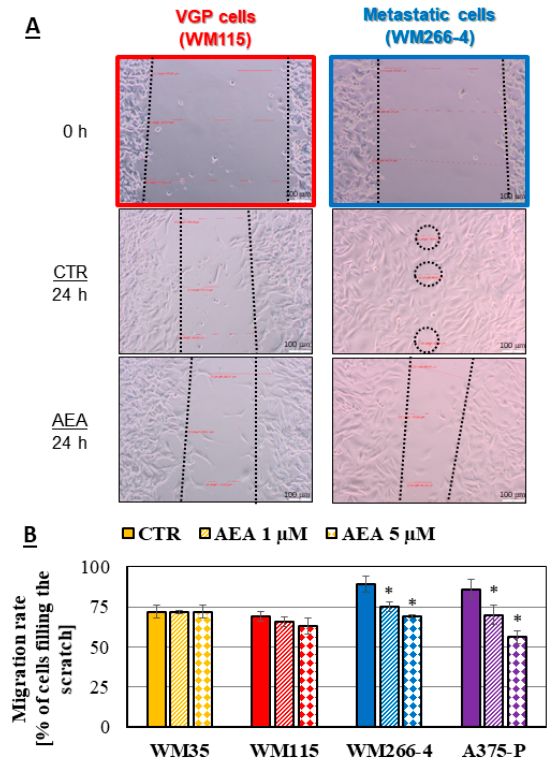
Figure 8. Migration rate analysis of melanoma cells: ( A )—the representative pictures of the closely related WM115 and WM266-4 melanoma cells (from the same patient) after creating the scratch (0 h) and 24 h later after the 1 µM AEA treatment (scale bar—100 µm). ( B )—the calculated migration rate of different melanoma cells after 1 µM and 5 µM AEA treatment. The statistical significance of the p -value below 0.05 (*) was marked on the graph.